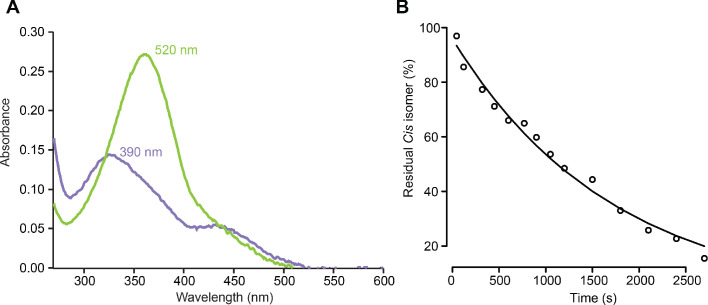
Photochemical properties of MAGu.(A) UV-visible spectra of MAGu under 520 nm light (green, mostly trans) or under 390 nm light (pink, mostly cis). (B) Thermal relaxation of cis MAGu in aqueous solution in darkness. Absorbance at 362 nm is plotted as a function of time in darkness following illumination with 390 nm light. Data points were fitted with the following monoexponential decay equation: y = A exp(-x/k) and yielded: A = 95.8 ± 1.9 and k = 5.8e-04 ± 0.2e-04 s−1. The half-life of cis MAGu was ln(2)/k = 1195 s.